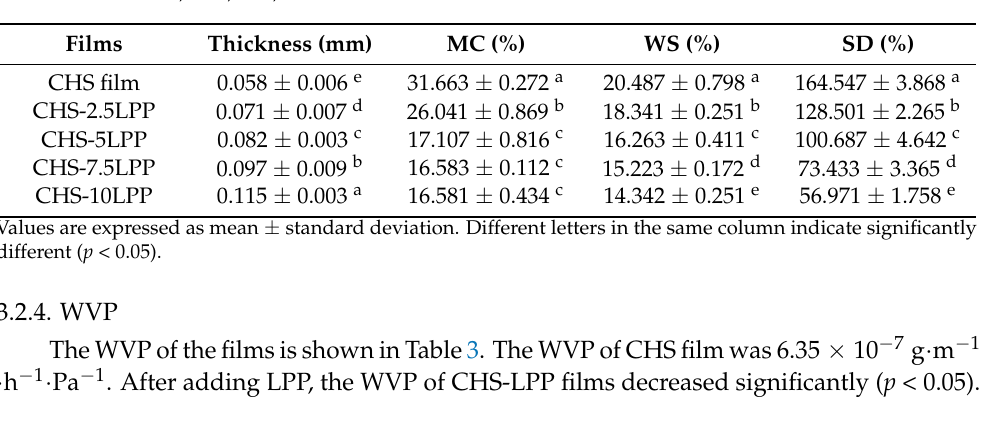
Table 2. Thickness, MC, WS, and SD of